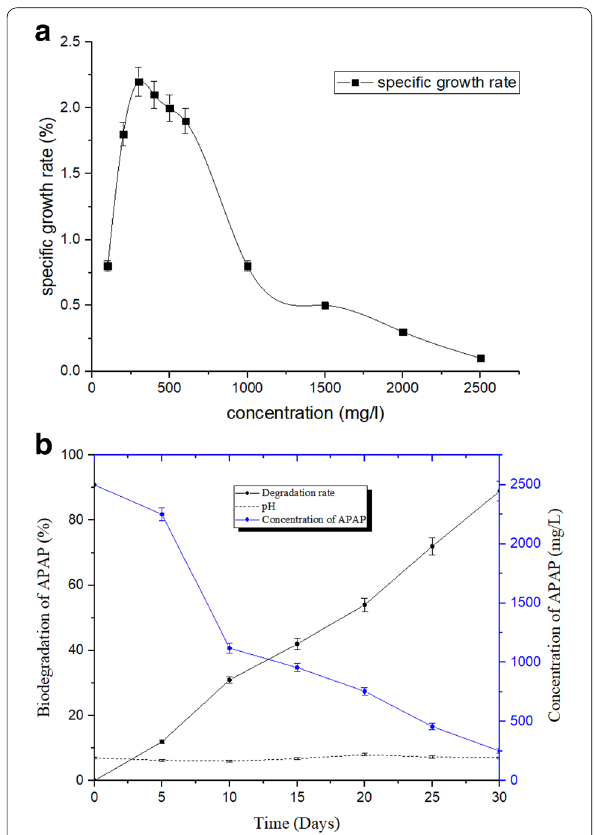
Fig. 4 a Specific growth rate curve of Bacillus drentensis strain S1; b utilization of APAP as a growth substrate by Bacillus drentensis strain S1 indicated degradation of APAP, COD and pH with respect to